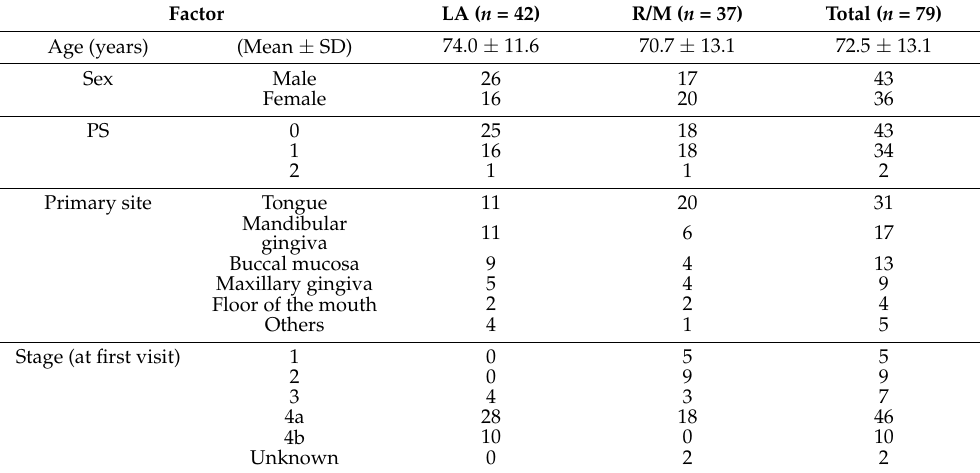
Table 2. Patient